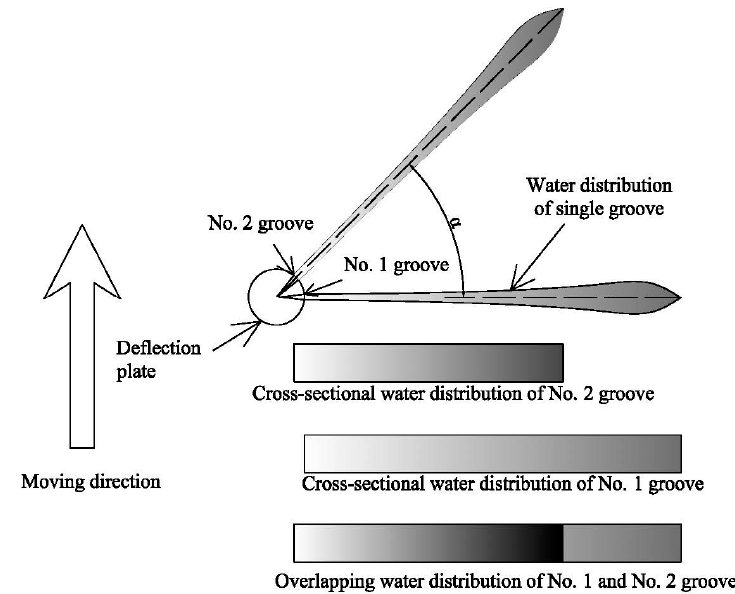
Figure 1. Sequential groove-by-groove process for determining the water distribution pattern from a sprinkler in motion. (1) Determine Water Distribution Pattern from a Single Groove